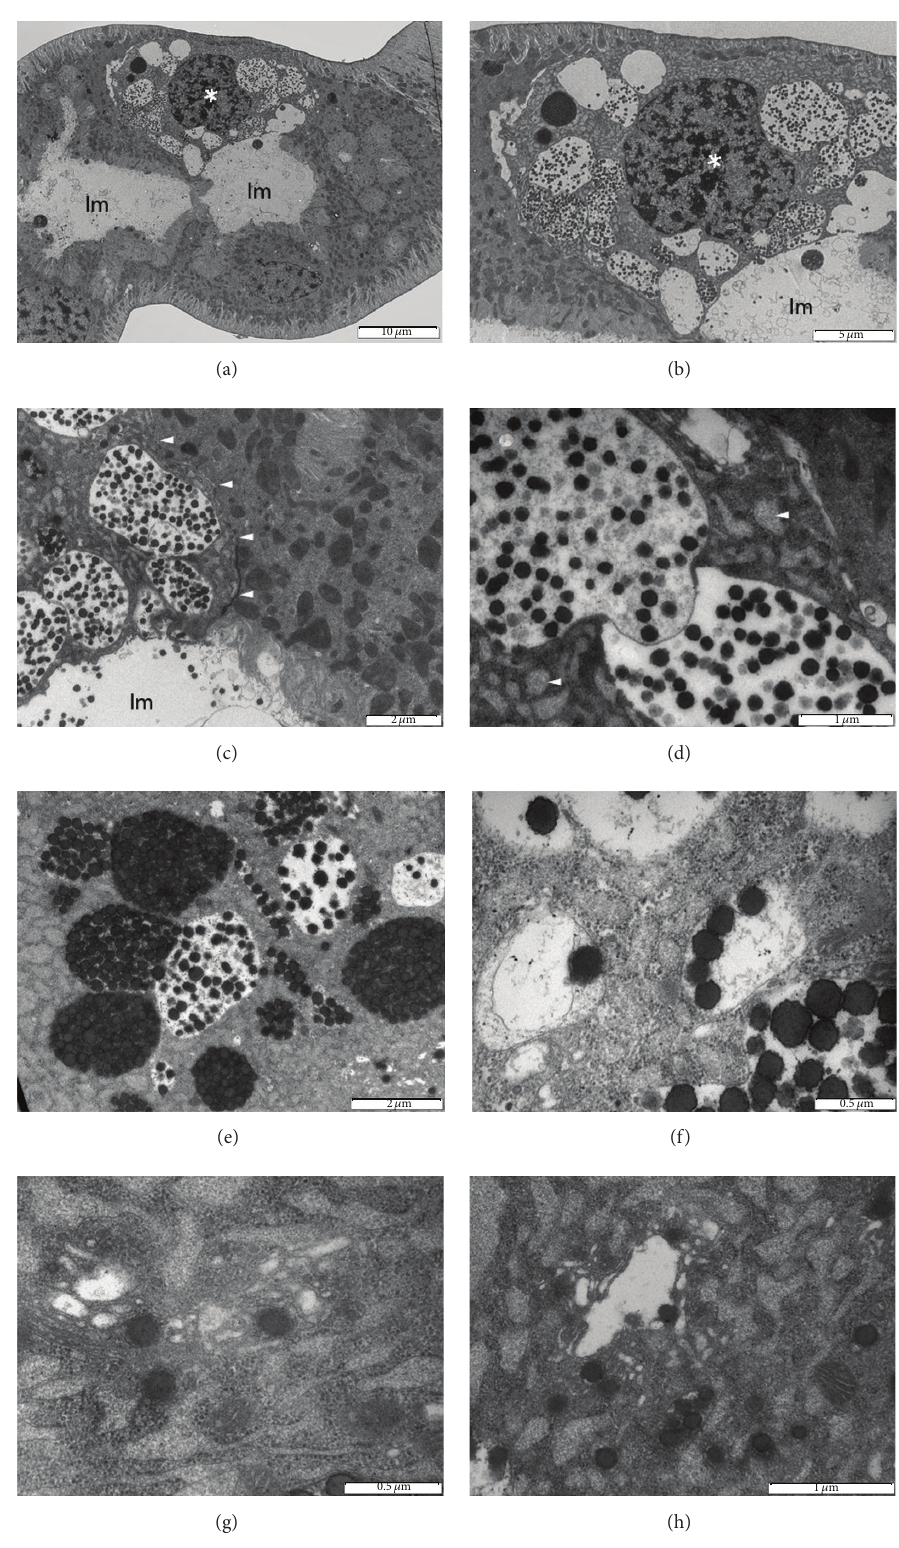
Figure 6: Secretory cells in the Malpighian tubules of Mapuchea chilensis . ((a)–(d)) Cells in the tubules of a 3rd instar nymph. (a) A single secretory cell (its nucleus marked by an asterisk) among excretory cells. (b) The same cell, closeup. (c) Contact between a secretory and an excretory cell; arrowheads point at the junction. Note secretory granules in the tubule lumen. (d) Secretory vacuoles with granules and additional particulate material. Arrowheads point at cisternae of endoplasmic reticulum. ((e)–(h)) Cells in the tubules of an adult. (e), (f) Secretory vacuoles variably loaded with granules. (g), (h) Golgi regions with developing granules. lm: tubule